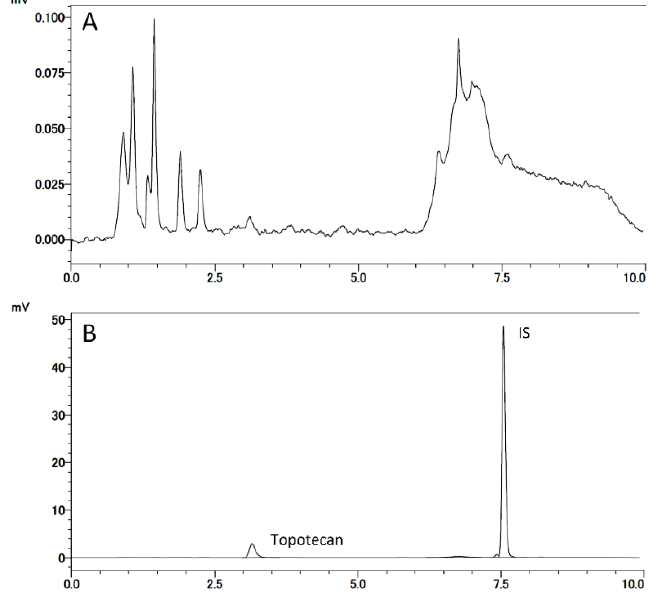
Figure 3. Chromatogram for the analysis of topotecan using the developed HPLC method. The re- tention times of topotecan (lactone form) and internal standard were 3.2 min and 7.5 min, respec- tively.